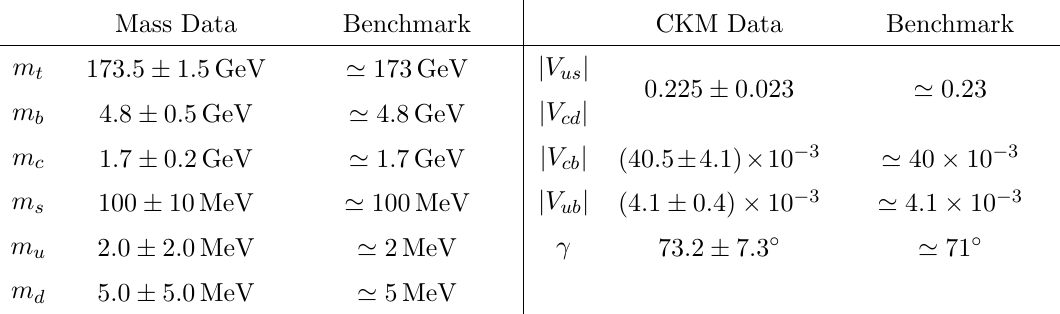
Table 1 . Data for quark (pole) masses and CKM parameters used in our analysis. The central values correspond to the measured quark masses [45] and CKM parameters [46, 47]. All CKM parameters and the b , c , and s quark masses are assigned 10% uncertainties. In the case of the top mass we use a 1.5 GeV uncertainty, while for the up and down masses we use 100% uncertainties. Also shown are predictions corresponding to the benchmark point